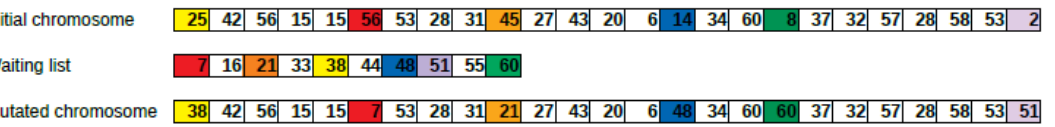
Figure 5. Example of mutation